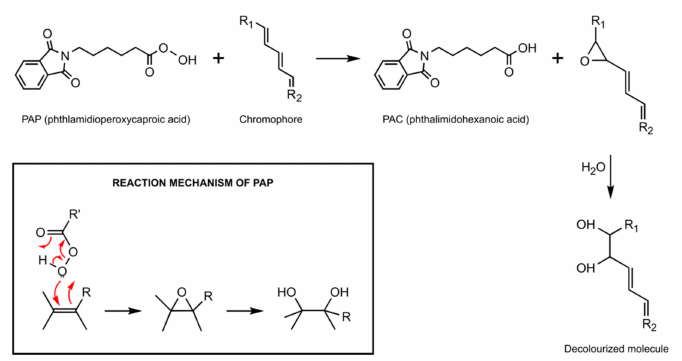
Figure 1. Mechanism of action of PAP on chromogens.